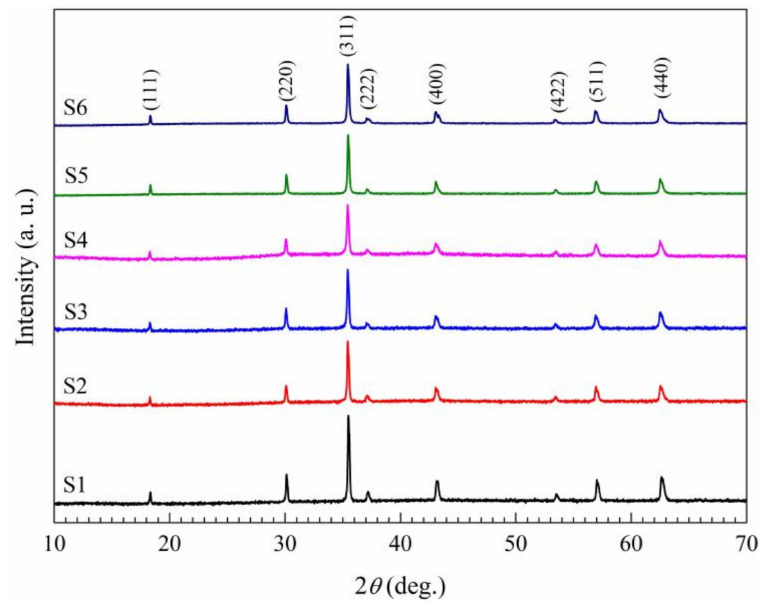
Figure 6. The XRD patterns of S1~S6 samples sintered at 1250 ◦ C. Table 2. The lattice parameters and densities of the sintered samples. Specimen Lattice parameters